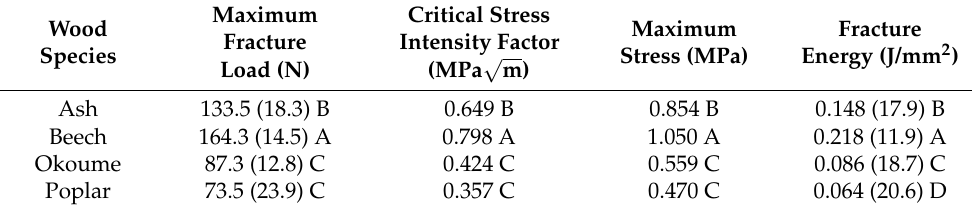
Table 2. Summaries of compact tension fracture characteristic values.